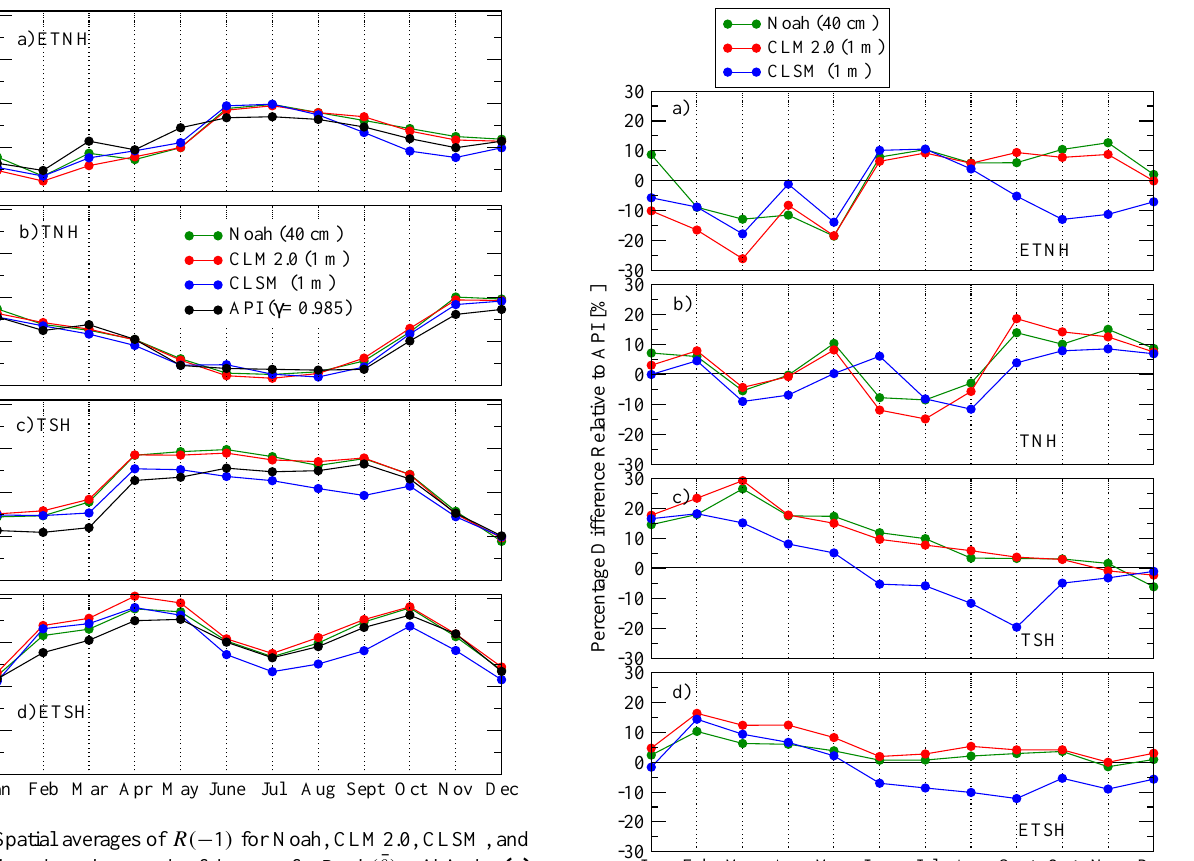
Fig. 9. Spatial averages of relative change in Noah, CLM2.0, and CLSM R( − 1 ) results versus the API baseline (i.e, 100 · [ R( − 1 ) − R( − 1 ) API ] /R( − 1 ) API ) broken down by month of LSM the year for Rank ( ¯ θ) within the (a) extra-tropical Northern Hemi- sphere (ETNH), (b) tropical Northern Hemisphere (TNH), (c) trop- ical Southern Hemisphere (TSH), and (d) extra-tropical Southern Hemisphere